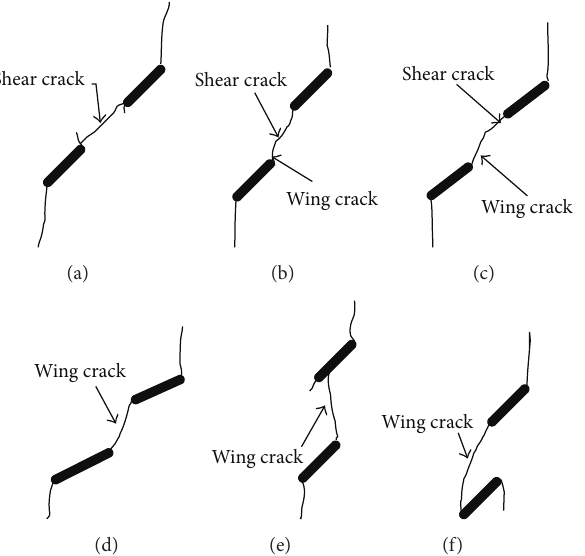
Figure 5: Six different patterns of crack coalescence were observed in the 2-flaw specimens. The notion of S, M, and W indicated the shear mode crack coalescence, mixed (shear/tensile) mode crack coalescence, and wing tensile mode crack coalescence (after Wong and Chau [46]).